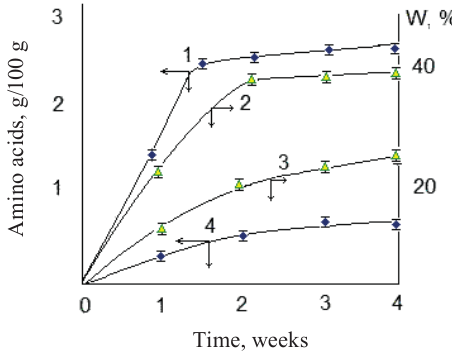
Time, Figure 1 Content of free amino acids (curves 1, 4) and water retention (curves 2, 3) vs. treatment time with Lactobacillus plantarum and Staphylococcus carnosus (1) and without